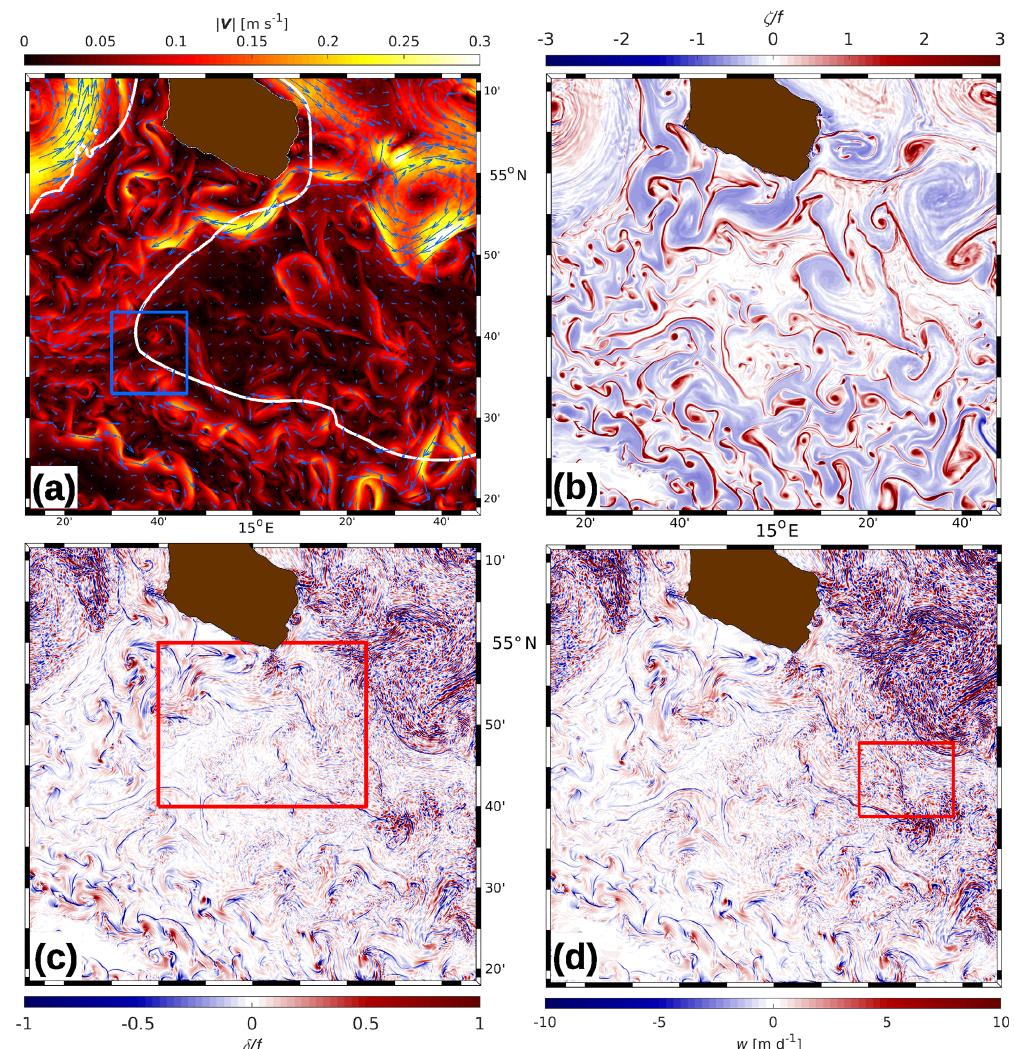
Figure 7. R100, 26 June: (a) magnitude and direction of top-layer horizontal velocity V (vectors are plotted at 3km resolution), (b) relative vorticity ζ and (c) horizontal divergence δ , each scaled by f , (d) vertical velocity w at 5m of depth. The white line in (a) is the 40m depth contour. The blue box in (a) refers to the zoomed area shown in Figs. 11 and 12, the box in (c) is the zoomed area of Fig. 8, and the box in (d) is the zoom shown in Fig.